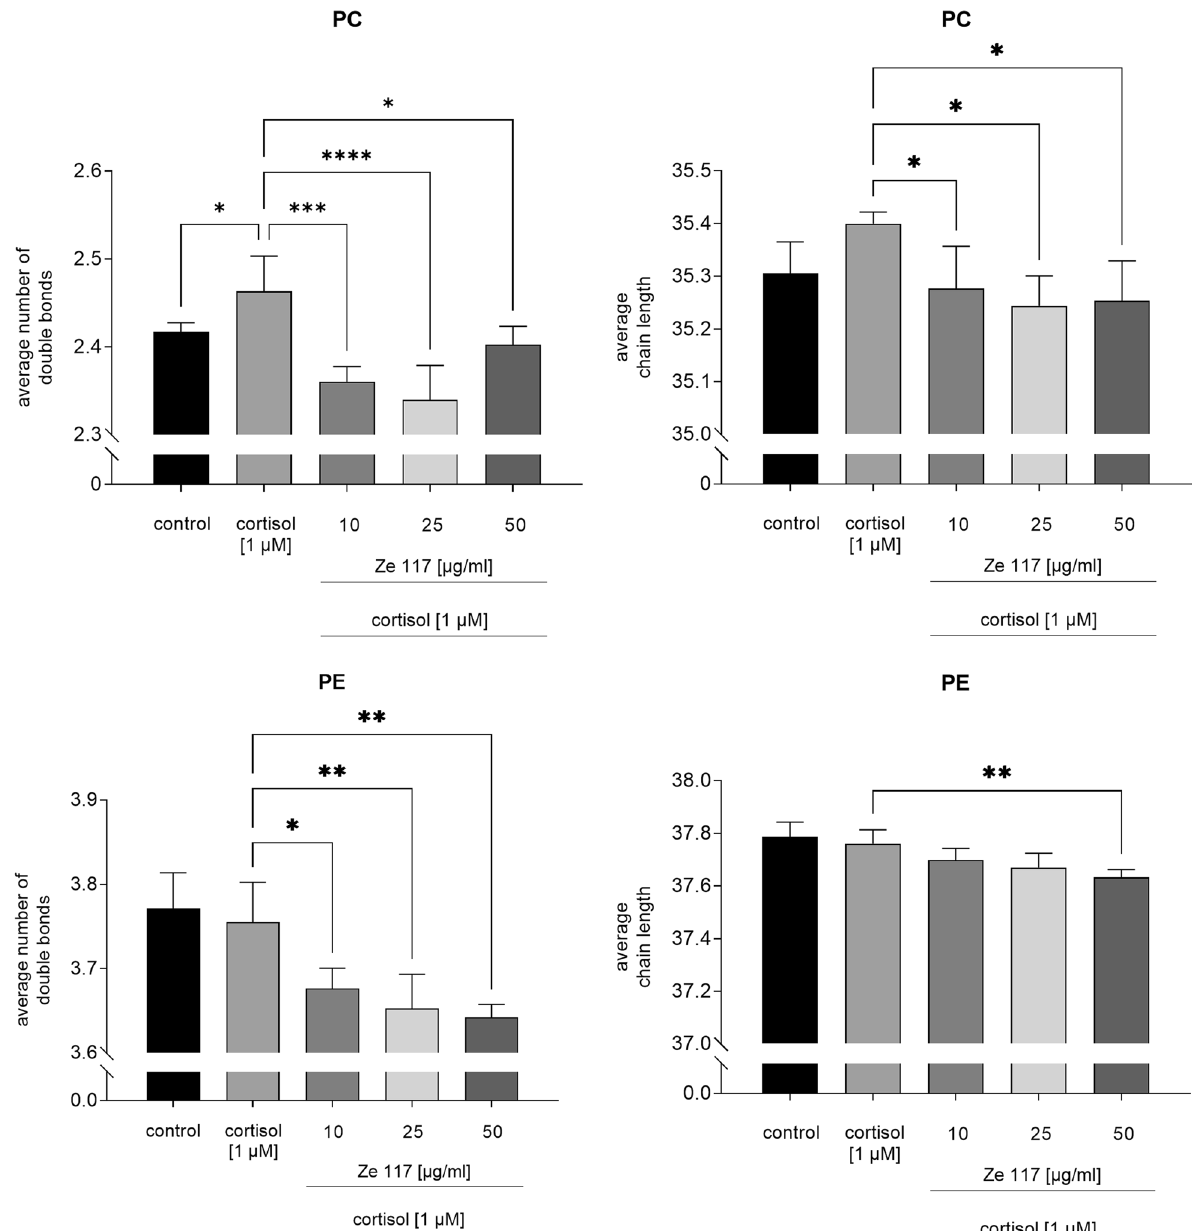
Fig. 4 Average chain length and average number of double bonds of phosphatidylcholines (PC) and phosphatidylethanolamines (PE) of PBMC after cortisol and cortisol/Ze 117 preincubation, respectively. For statistical evaluation the cortisol condition was compared to the control. Average chain length and average number of double bonds of cortisol/Ze 117 pre-treated cells were compared to the cortisol condition. *Marked values are significantly different from corresponding control with p < 0.05 (**p < 0.01, ***p < 0.001, ****p < 0.0001) determined by one-way ANOVA (n followed by Holm-Šídák